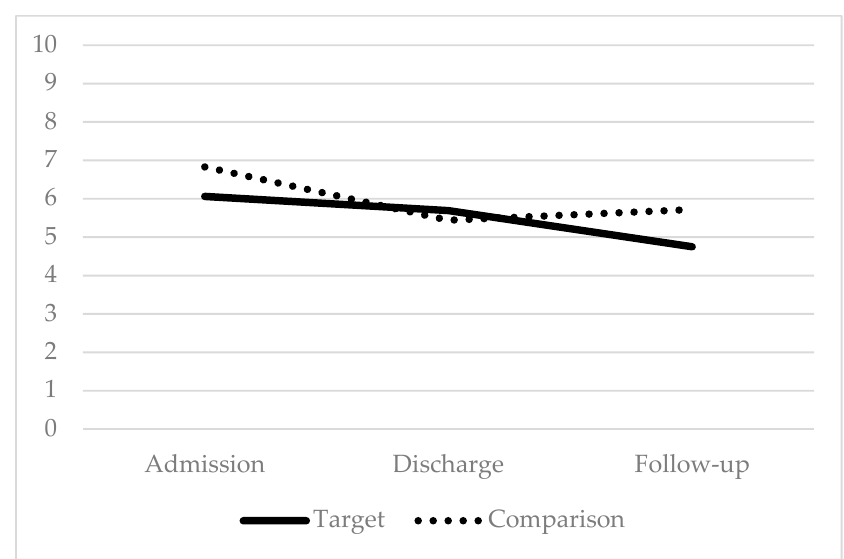
Figure 3. Average pain intensity: lower scores indicate improvement.